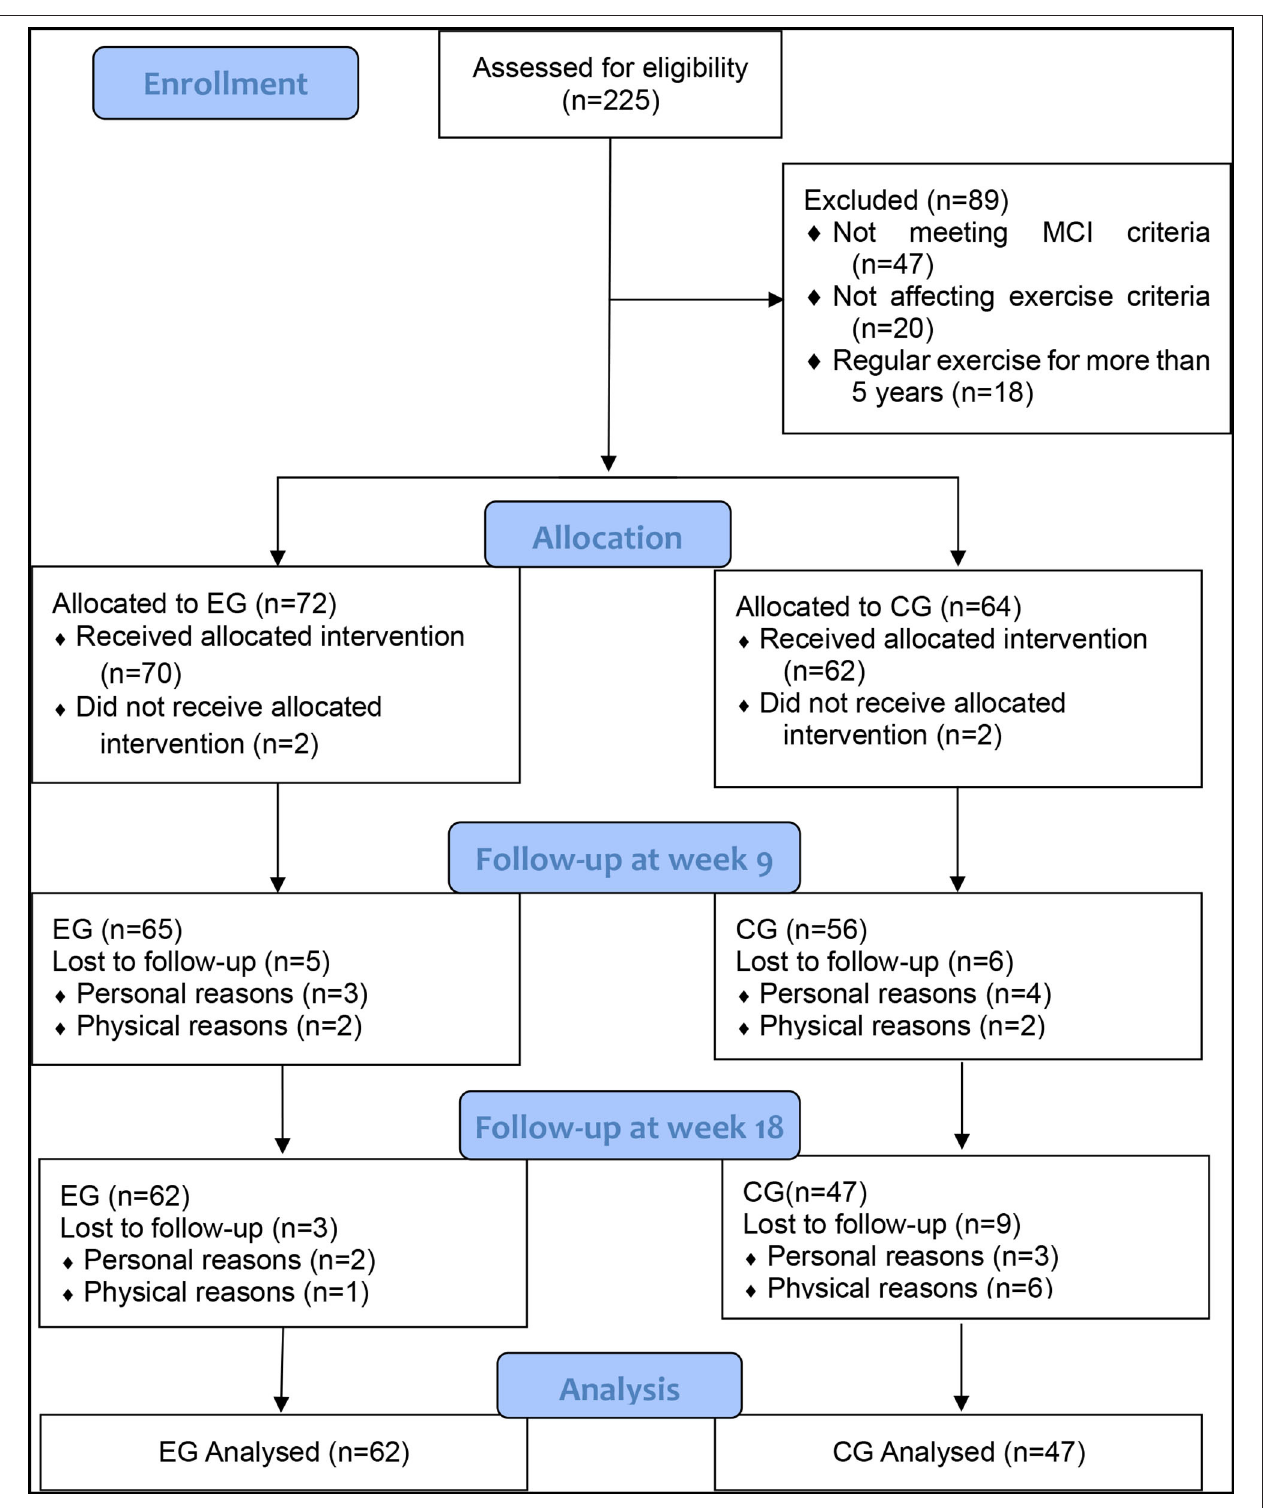
FIGURE 1 | Flowchart of participant